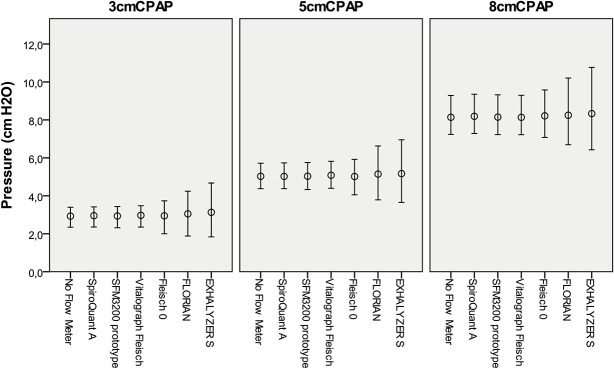
Pressure swings for Infant Flow with flow meters.Simulations using flow-through measurement at three levels of CPAP with 32 ml tidal volume breathing. The circle indicates mean pressure (CPAP) and the bar the mean highest and lowest pressure (the amplitude represent pressure swing) for 20 consecutive breaths. Complete data including variance is available as supplemental information (S2 Table).